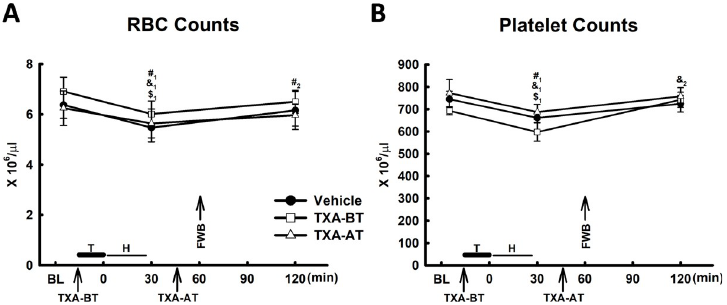
Fig 6. RBC and platelet counts (n = 10 per group). T: Trauma; H: Hemorrhage; FWB: Fresh Whole Blood; A: RBC counts; B: Platelet Counts. #: Vehicle; &: TXA-BT; $: TXA-AT. # 1 , & 1 and $ 1 : significant difference compared to baseline (BL); # 2 , & 2 and $ 2: significant difference compared to